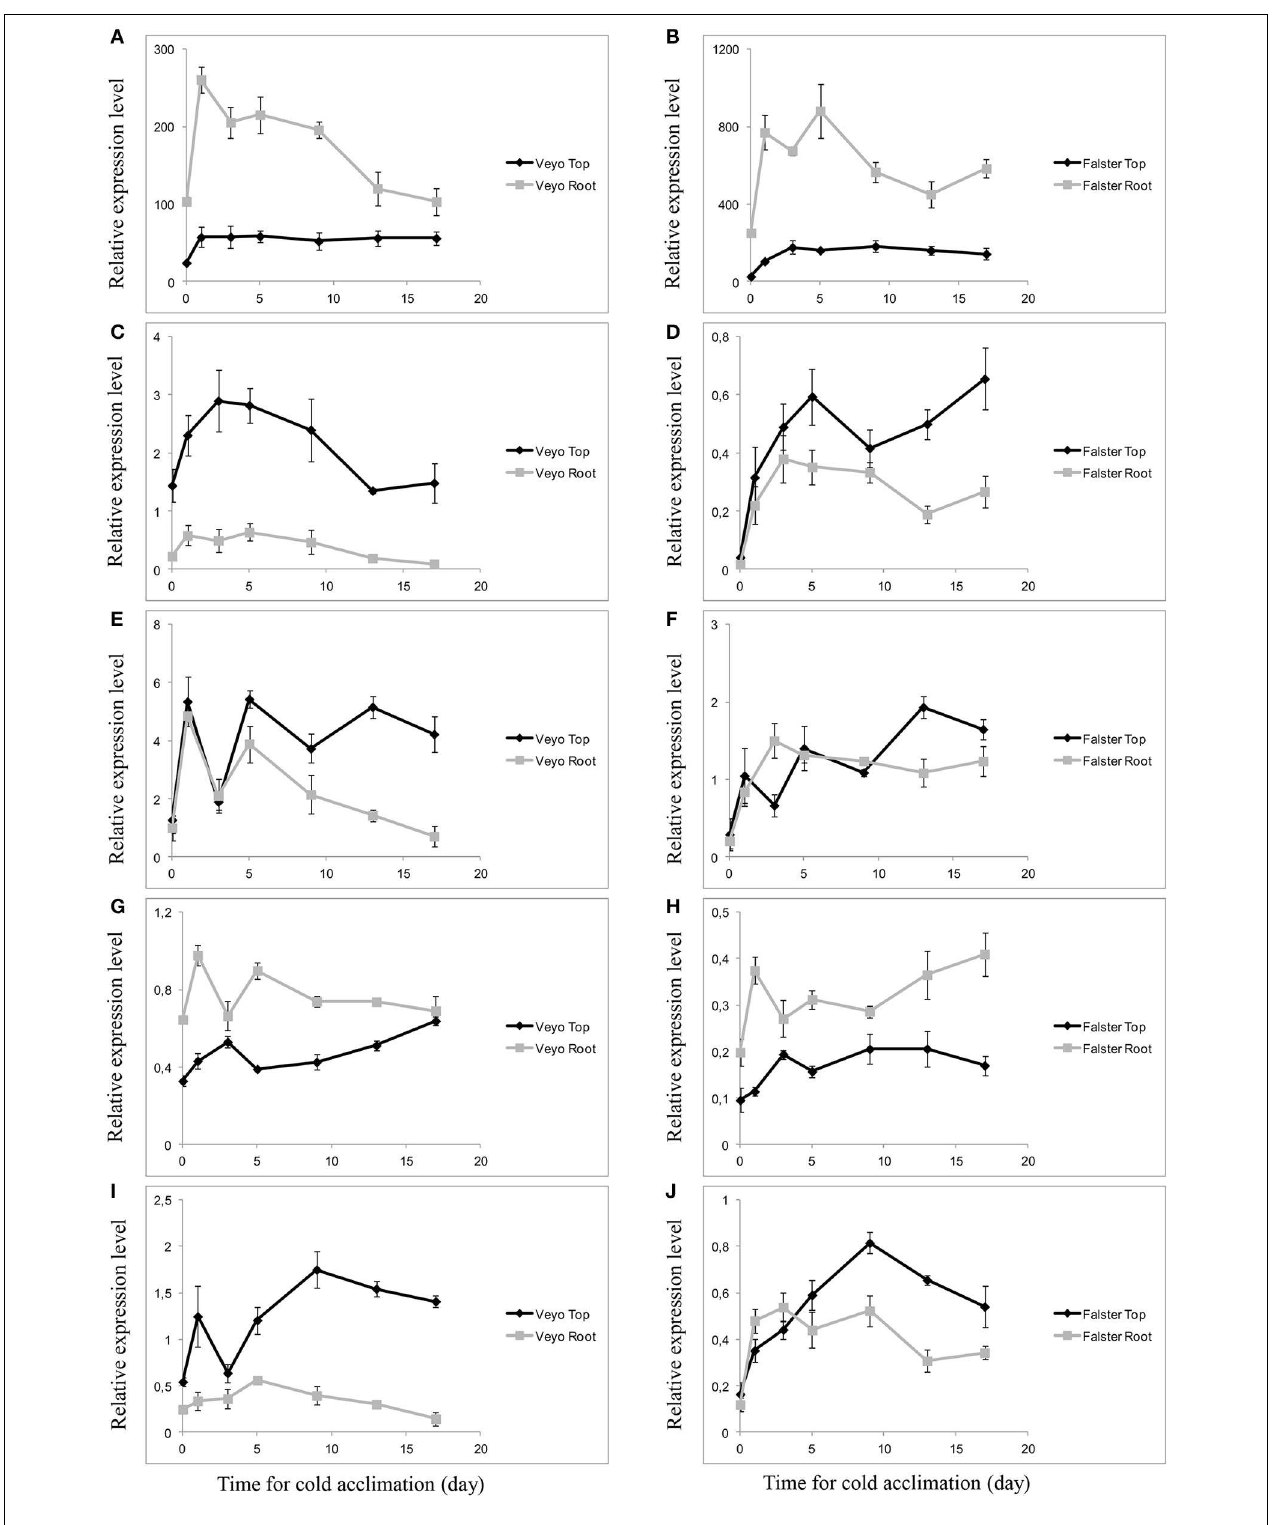
FIGURE 7 | Differential expression of fructan-related genes in the green tissues (top) and root tissues of perennial ryegrass ( Lolium perenne L.) variety “Veyo” and ecotype “Falster” during cold acclimation. (A,B) Sucrose: sucrose 1-fructosyltransferase ( Lp1-SST) .